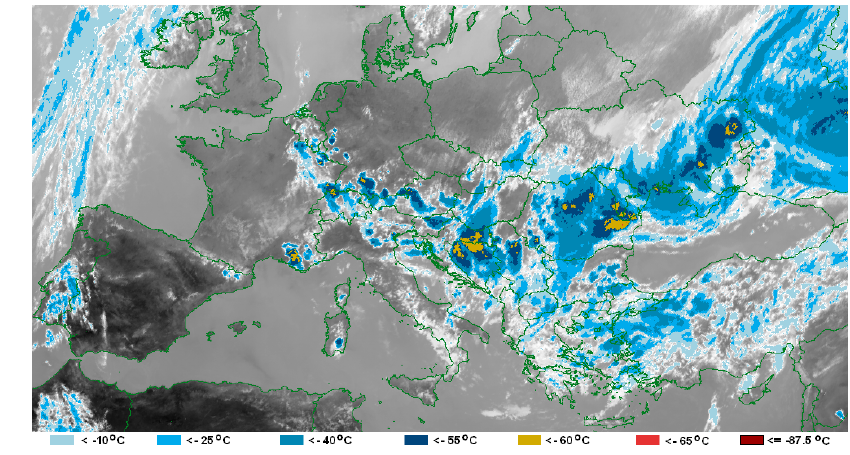
Figure 7 – MSG1 RGB satellite image of the cloud